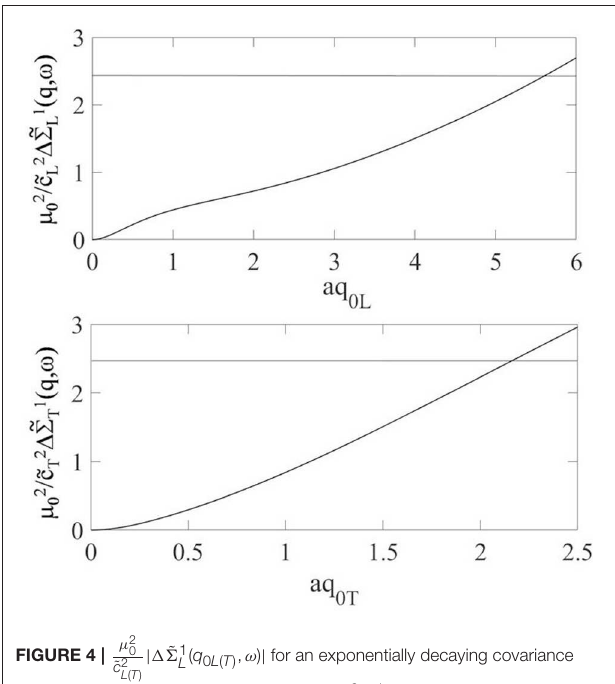
function. The straight line fixes the value of ( ˜ ǫ 2 ) − 1 . The values of the theory’s input parameters are listed in the text.